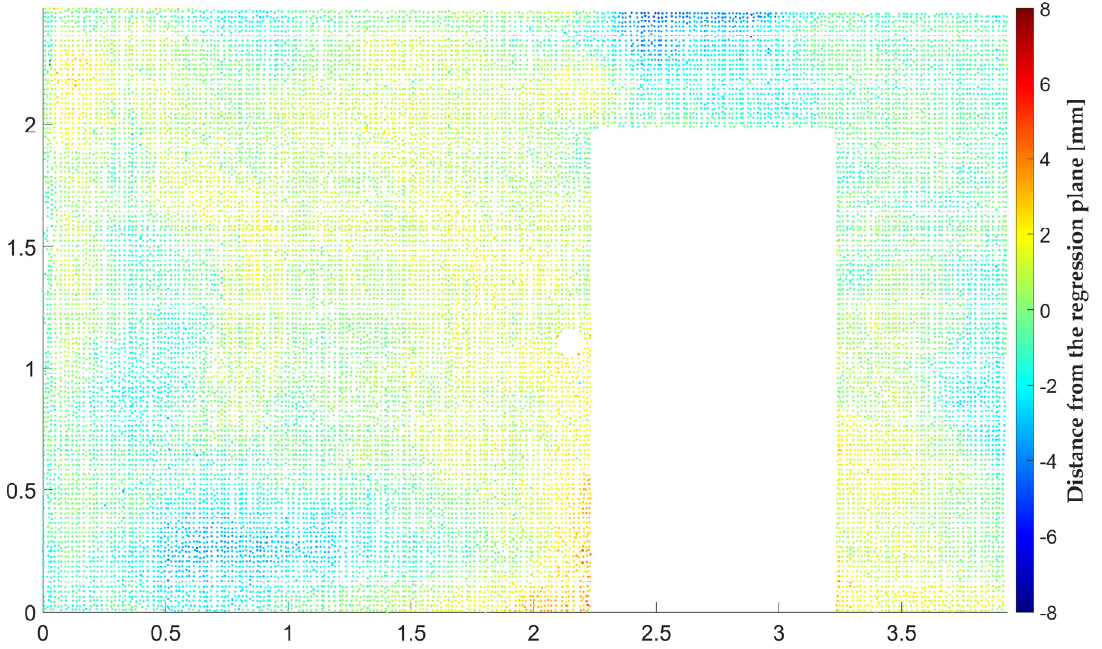
Figure 7. Deviation map for the wall flatness